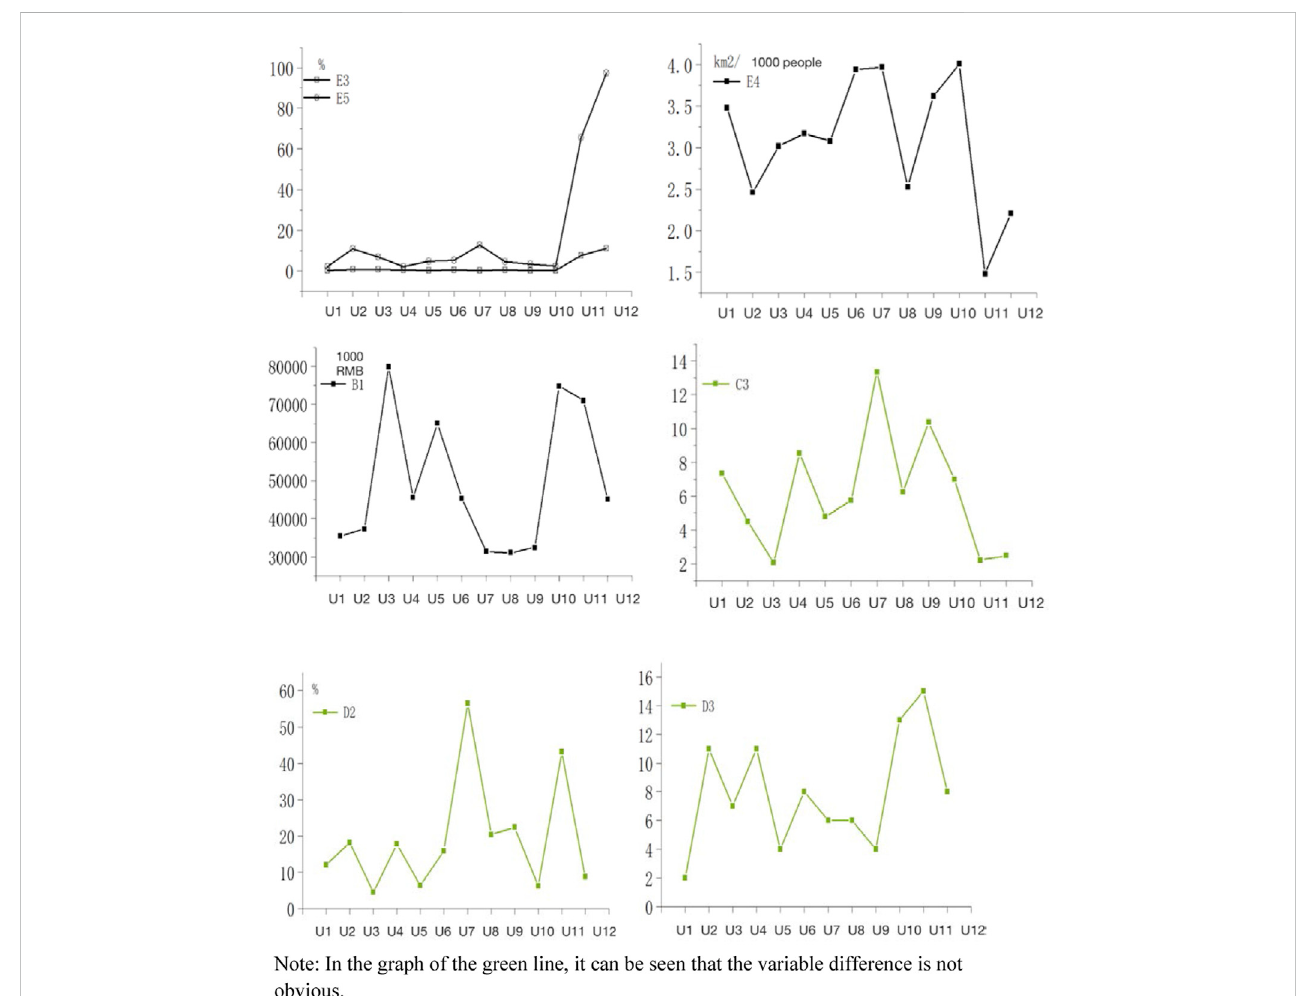
FIGURE 4 The distribution of each signi fi cant variable in the